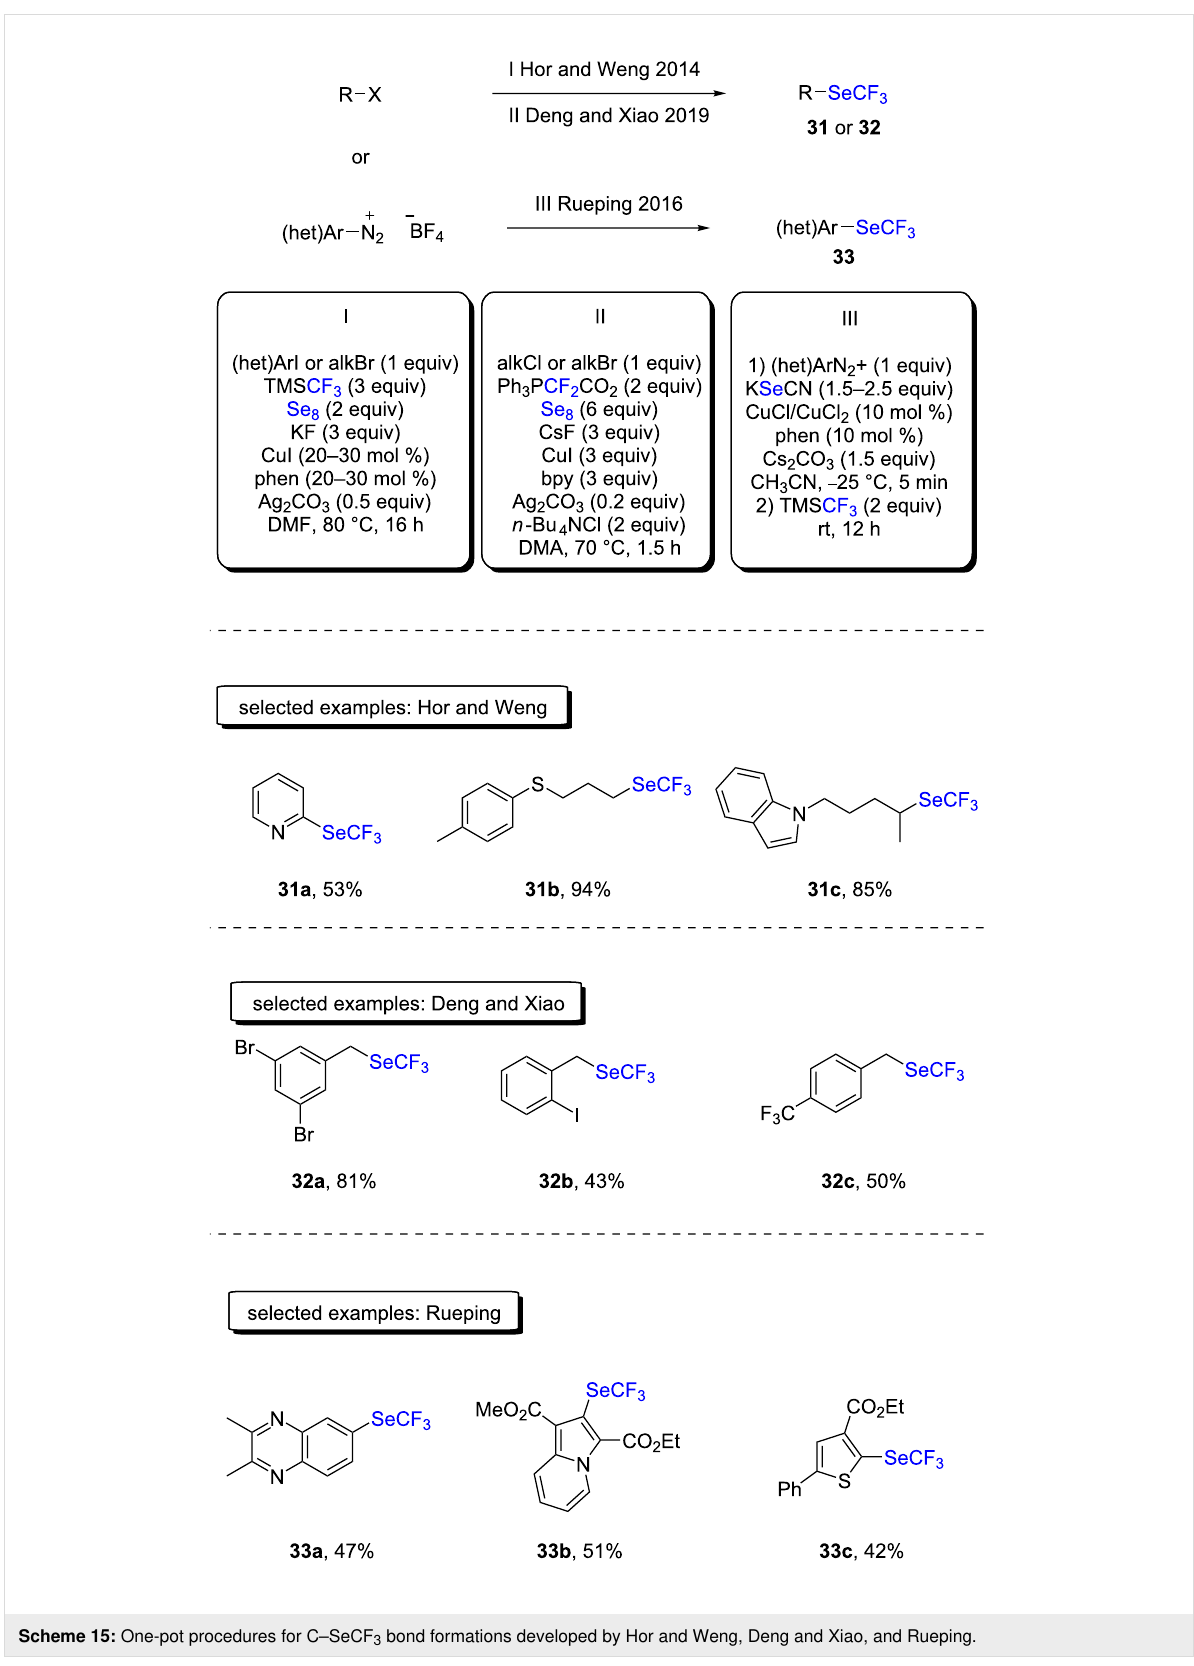
Scheme 15: One-pot procedures for C–SeCF 3 bond formations developed by Hor and Weng, Deng and Xiao, and